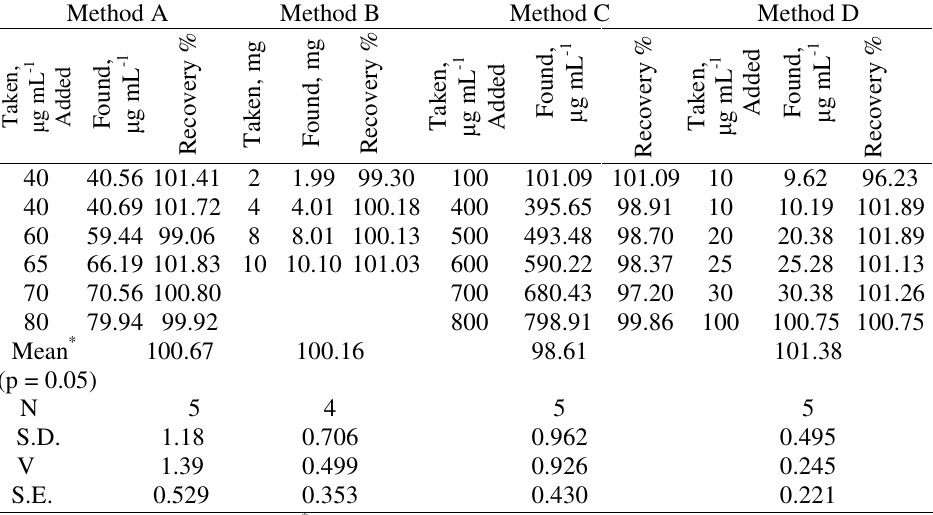
Table 3. Determination of gaptin capsule by using methods (A-D)